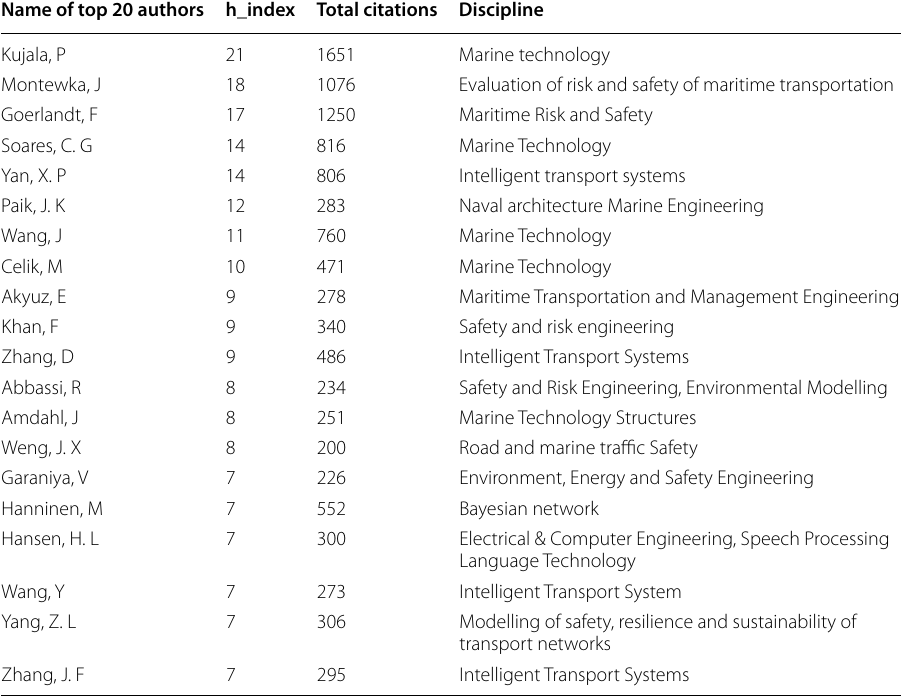
Accidents” based on +